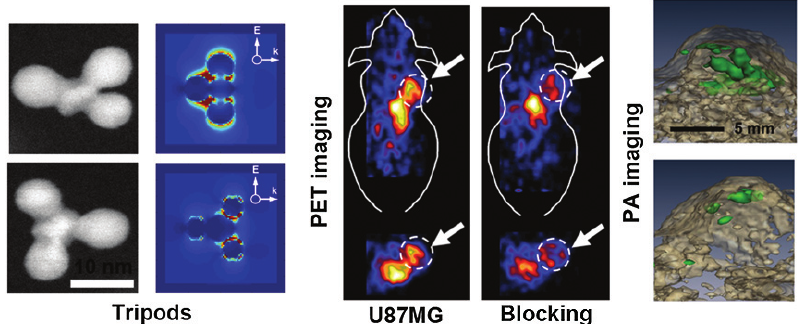
Fig. 2. Structure of gold-based tripod and their PET and PA imaging of xenografted animals. Scanning transmission electron microscope images of tripod-T (A) and tripod-A (B) are de¯nitively identi¯ed. Polarization dependence of the average electric ¯eld intensity of them localized the edges of tripods and the junctions between two Au (cid:2) Au NPs as enhanced ¯elds separately in (C) and (D). Small animal PET and PA images of intravenous injected tripods which functionalized ligands of cancer biomarkers (E, G) and blockings (F, H) in mice bearing the U87MG human glioblastoma are shown respectively [Adapted from Cheng, K and reproduced with permission of ACS Publications].